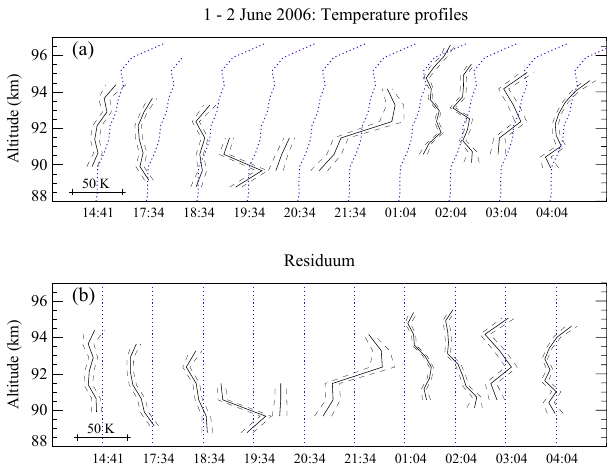
Fig. 5. Hourly mean temperature profiles (a) and their differences from the mean temperature (b) are plotted in this figure. The cor- responding time is given underneath each profile. The temperature profiles are moved by 50K from one profile to the next one. The dotted lines in (a) represent the mean temperature profile, the ones in (b) the 0K.